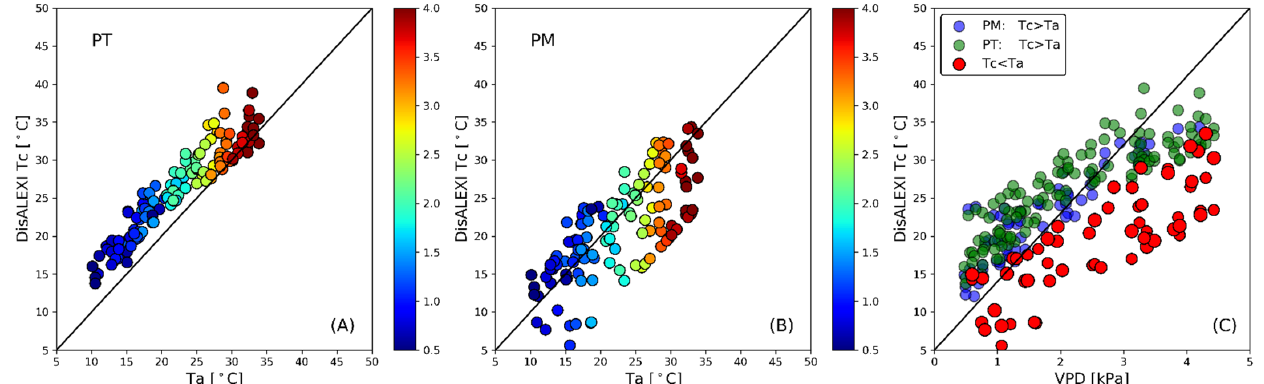
Figure 6. Scatter plot comparison of T a (x-axis; ( A , B )) and DisALEXI T c (y-axis) for DisALEXI-PT ( A ) and DisALEXI-PM ( B ), with color-scale indicating VPD values for all sites. Additionally included is a scatter plot of DisALEXI T c (y-axis; ( C )) and VPD (x-axis; ( C )) for all sites. The blue and green dots